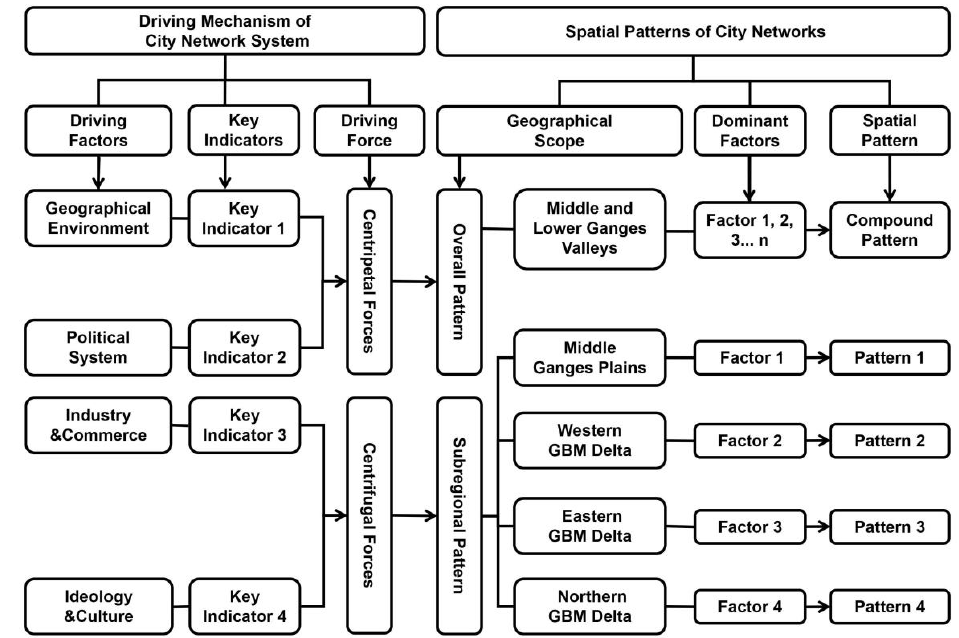
Figure 2. Analysis of driving mechanism and spatial patterns of city networks in the middle and lower Ganges Valley. Source: the authors. lower Ganges Valley. Source: the